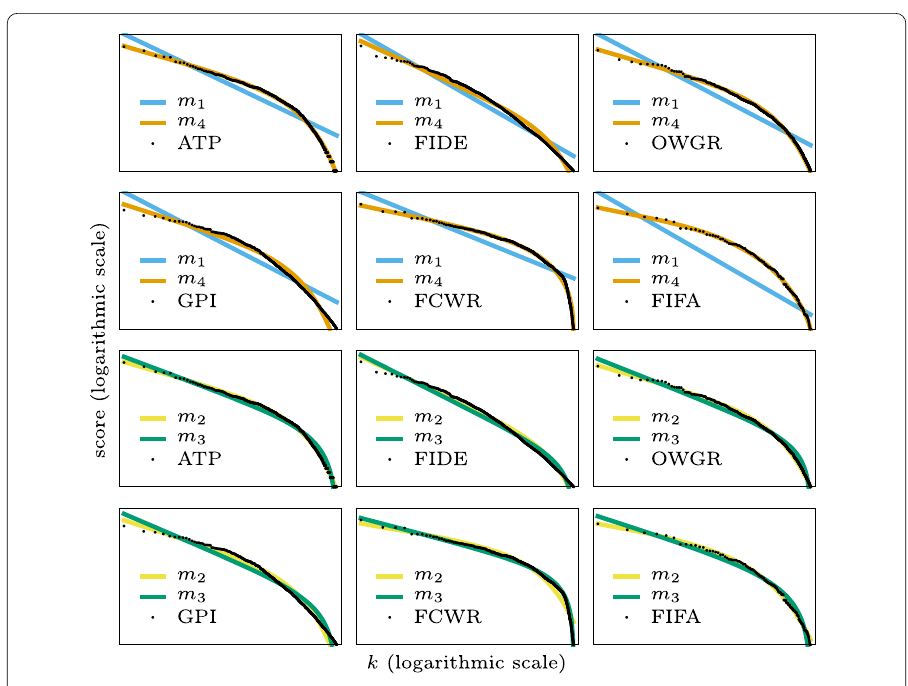
Figure 1 Comparison of ranking data with several models. Plot showing the rank distributions (score versus rank k ) for all sports considered in this study, at one time slice, as well as their fits with the four models in Eqs. (1)-(2). In general, Zipf’s law ( m 1 ) does not accurately reproduce the ranking of any sport or game reported here. Both the Gamma ( m 2 ) and Beta ( m 3 ) distributions seem to be appropriate in some cases. Overall, most datasets are well fitted by a combination of both functions, model m 4 . Although these plots correspond to one time slice only, results are representative of the entire datasets (see Table 3 for further details). For the sake of clarity, m 5 and tick labels are not